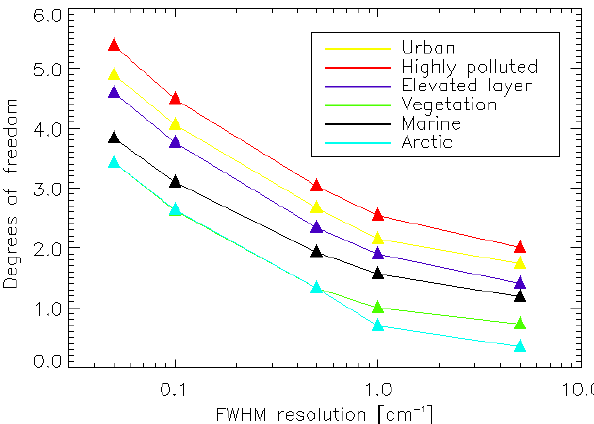
Figure 6. DoF comparison for the different aerosol scenarios. S a = 0.2 (44.7% relative error) and ω = 0.95 for the a priori aerosol extinction profile uncertainty and single scattering albedo are as- sumed. SZA = 45 ◦ and a 30 ◦ off-nadir instrument viewing geome- try have been used in all the